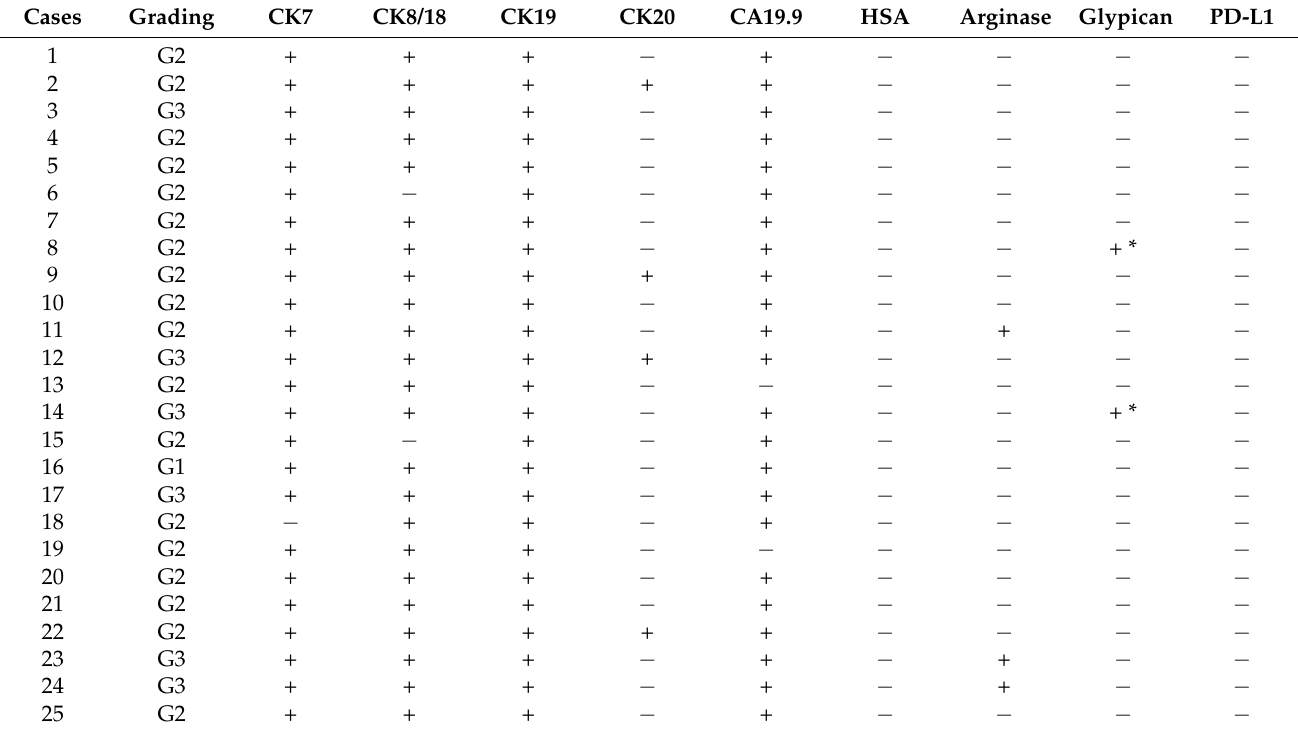
Table 2. Immunohistochemical characteristics of the patient samples.